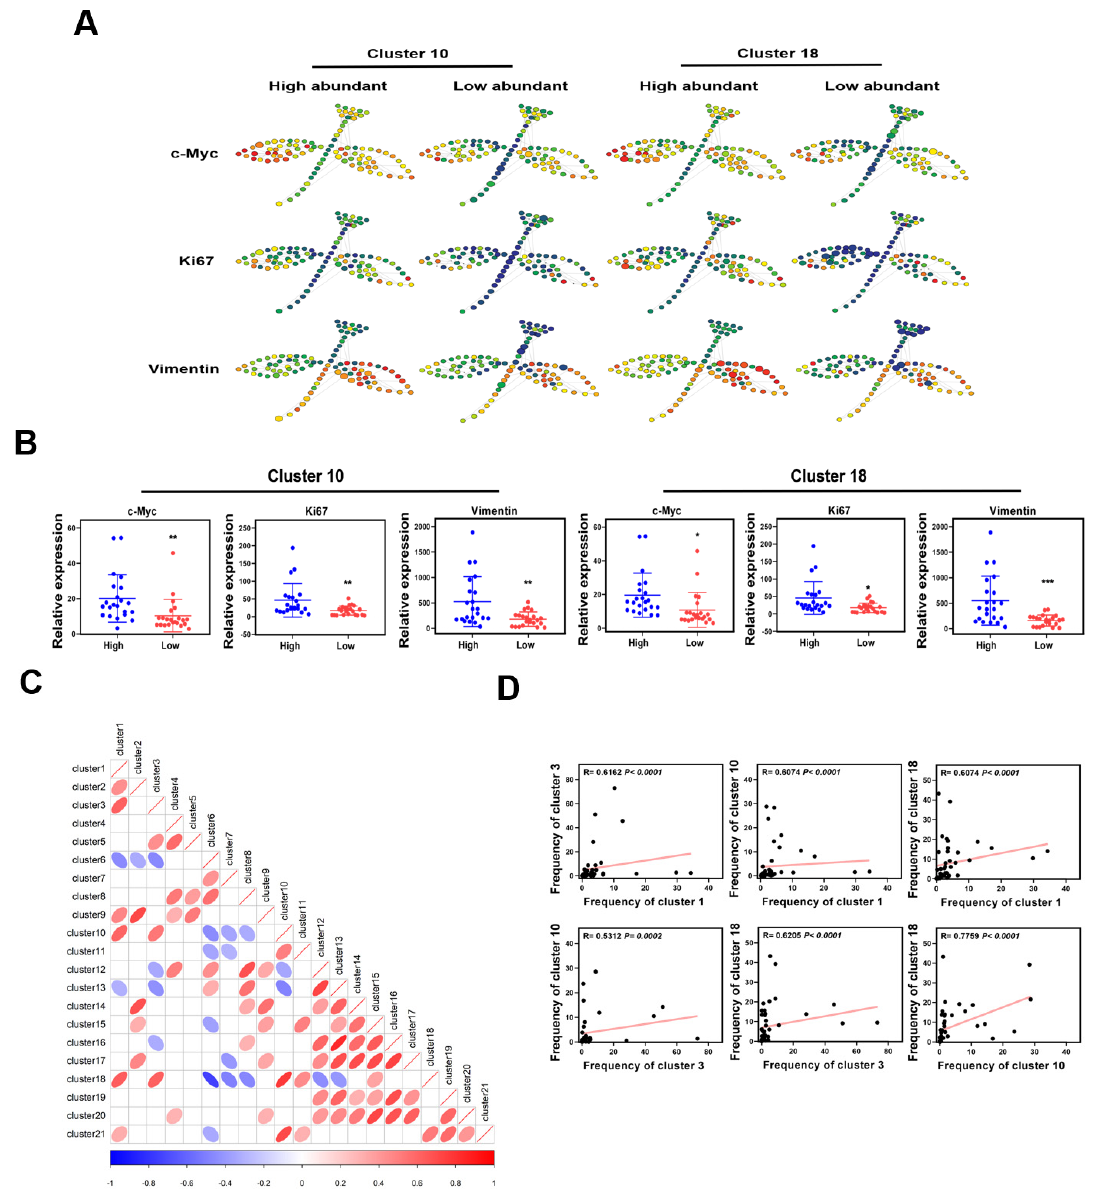
Figure 1. TME landscape in MIBC. ( A ) t-SNE plots of indicated markers of single cells from all samples. ( B ) t-SNE plots of the distinct clusters from cancer (CA) and para-carcinoma (CP) tissues. ( C ) Relative frequencies of 21 clusters in CA and CP tissues. ( D ) Heatmap of indicated markers expression of 21 clusters. ( E ) Relative frequencies of 21 clusters in individual samples.